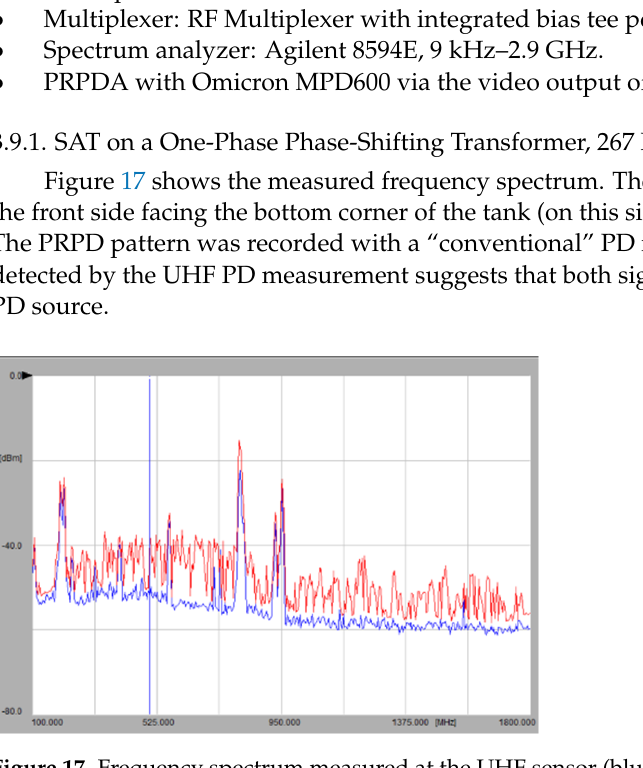
Figure 17. Frequency spectrum measured at the UHF sensor (blue curve: ground noise, red curve: PD signal, blue vertical marker at 500 MHz).